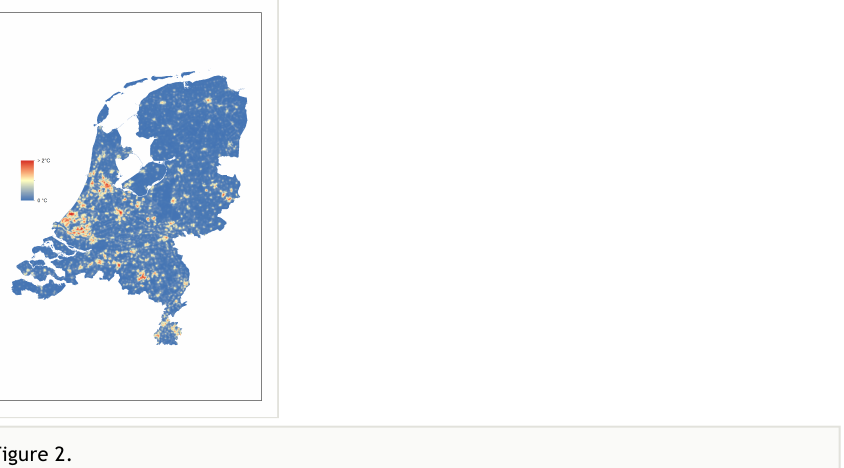
Average daily maximum UHI map for the Netherlands.